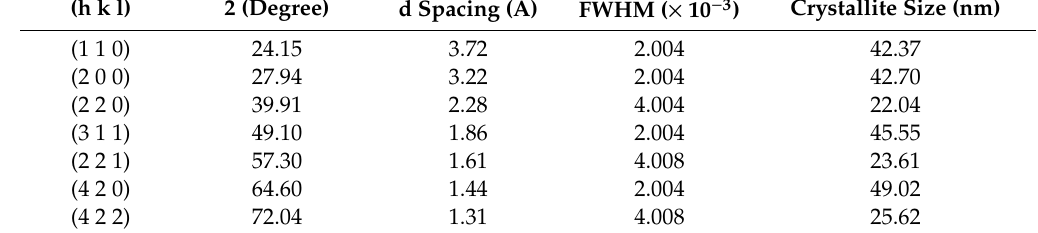
Table 1. X-ray di ff raction (XRD) analysis of the PbTe powder for sample A4.